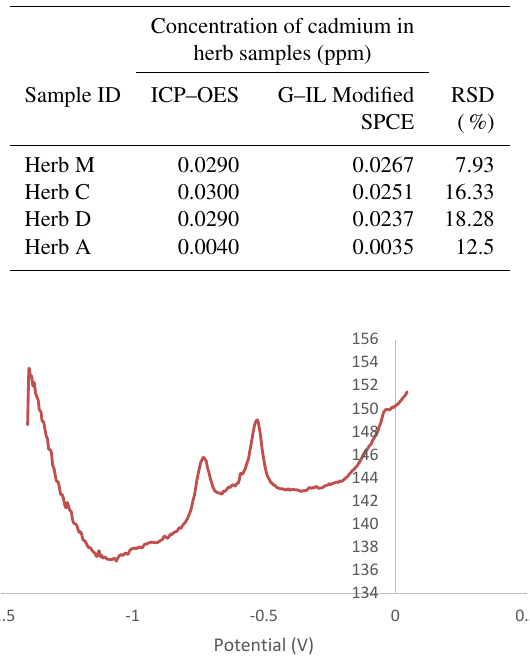
Figure 6. Voltammogram of interference study conducted from a standard composite mixture of Pb, Cd, Zn, As and